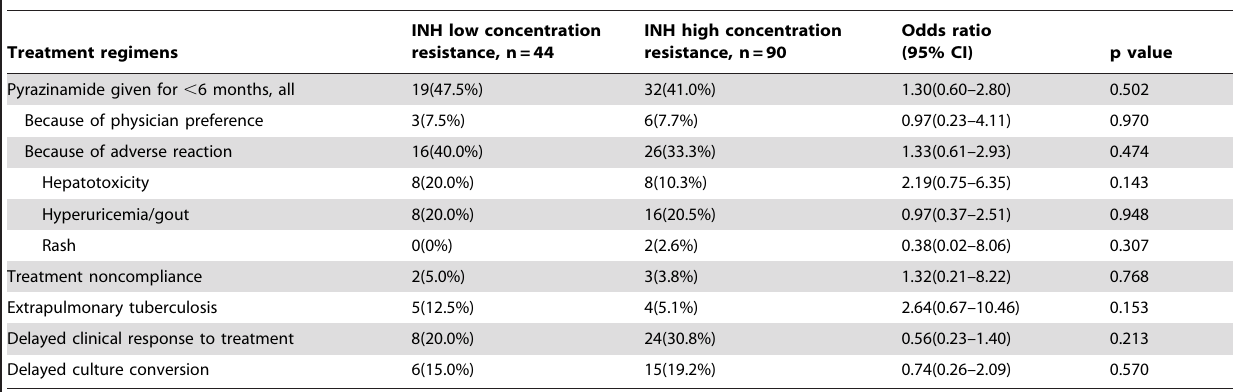
Table 3. Reasons for extension of treatment beyond 6 months.